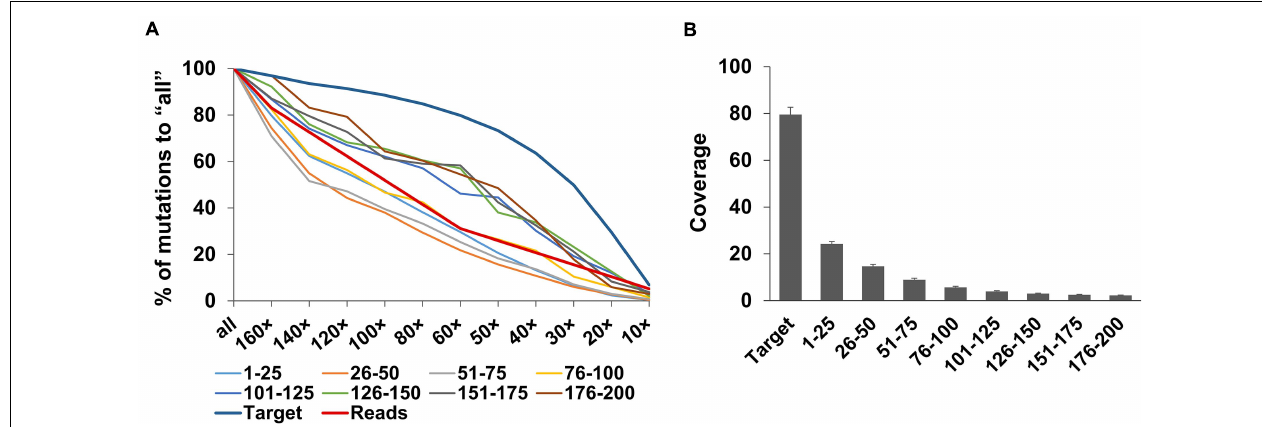
FIGURE 5 | Changes in the number of detected mutations and coverage in the target and flanking regions. (A) Percentages of the mutations detected in the target and flanking regions (25-bp bins from the end of the target regions: 1–25 to 176–200) in the down-sampled sequencing reads (160 × , 140 × , 120 × , 100 × , 80 × , 60 × , 50 × , 40 × , 30 × , 20 × , and 10 × total CDS length equivalent) to those by all the clean sequencing reads (“all”). Red line indicates the change in the percentage of each number of sequencing reads to that of “all.” (B) Coverage in the target and the flanking regions at 160 × by whole-exome sequencing. Bars indicate the mean and SD in the 19 NtEMS